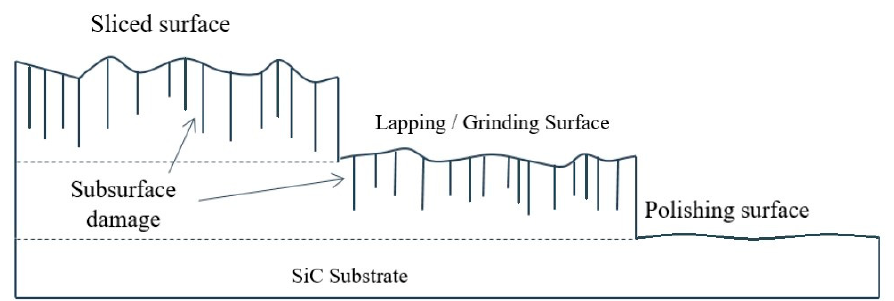
Figure 1. Illustrations of surface roughness and subsurface damage depth at the slicing, lapping, grinding and CMP steps of the SiC wafer production process [3].